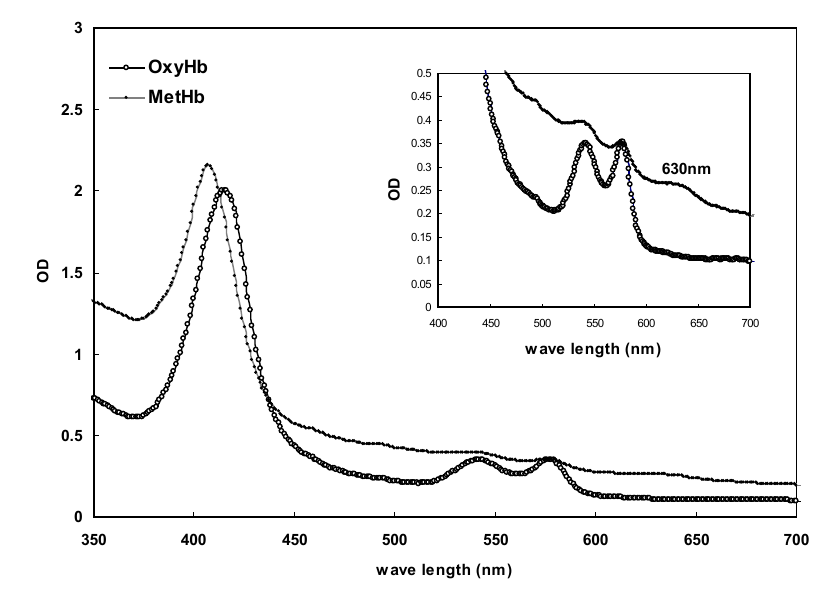
Figure 1. Absorption spectra for oxyhemoglobin and methemoglobin for human hemoglobin before and 1 hour after addition of 300 mL of dust supernatant in 0.1 M phosphate buffer pH 7 in the range of 350-700 nm wavelengths